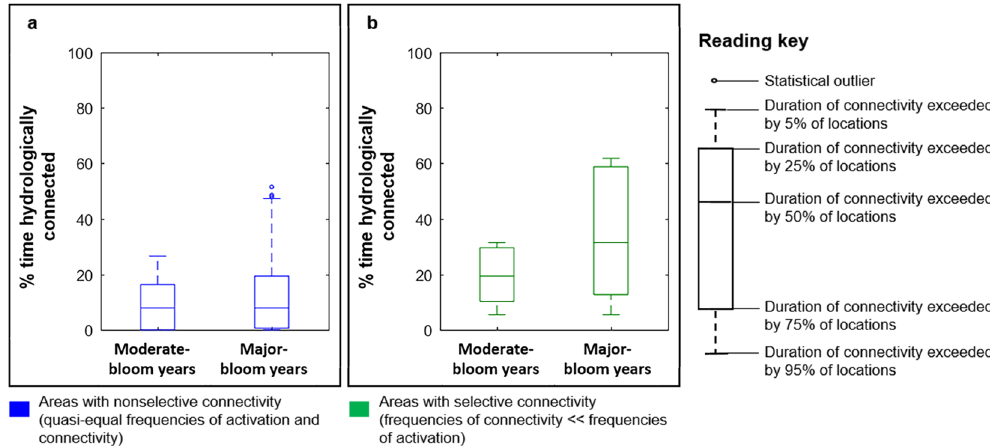
Figure 7. Linkage between connectivity duration and lake phytoplankton blooms. ( a ) Differences in connectivity duration between moderate-bloom years and major-bloom years for non-selectively connected areas only. ( b ) Same analysis but for selectively connected areas only. The plots were created using MATLAB (version R2016a,